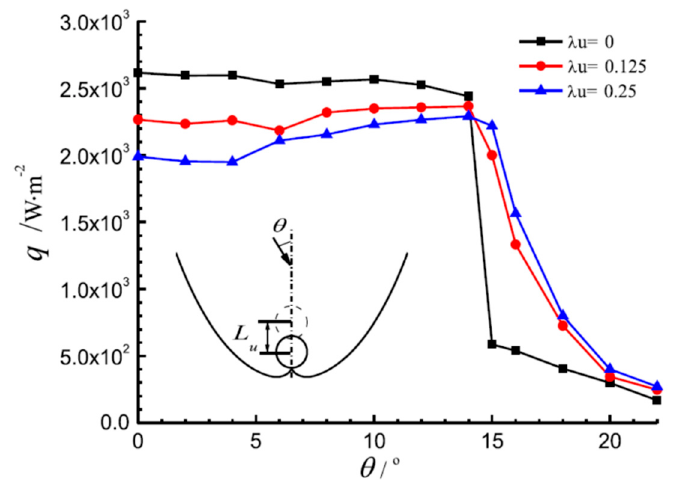
Figure 9. The average heat flux density on the absorber with translation of the CPC reflector ( C = 4, Ct = 0.5) [31].